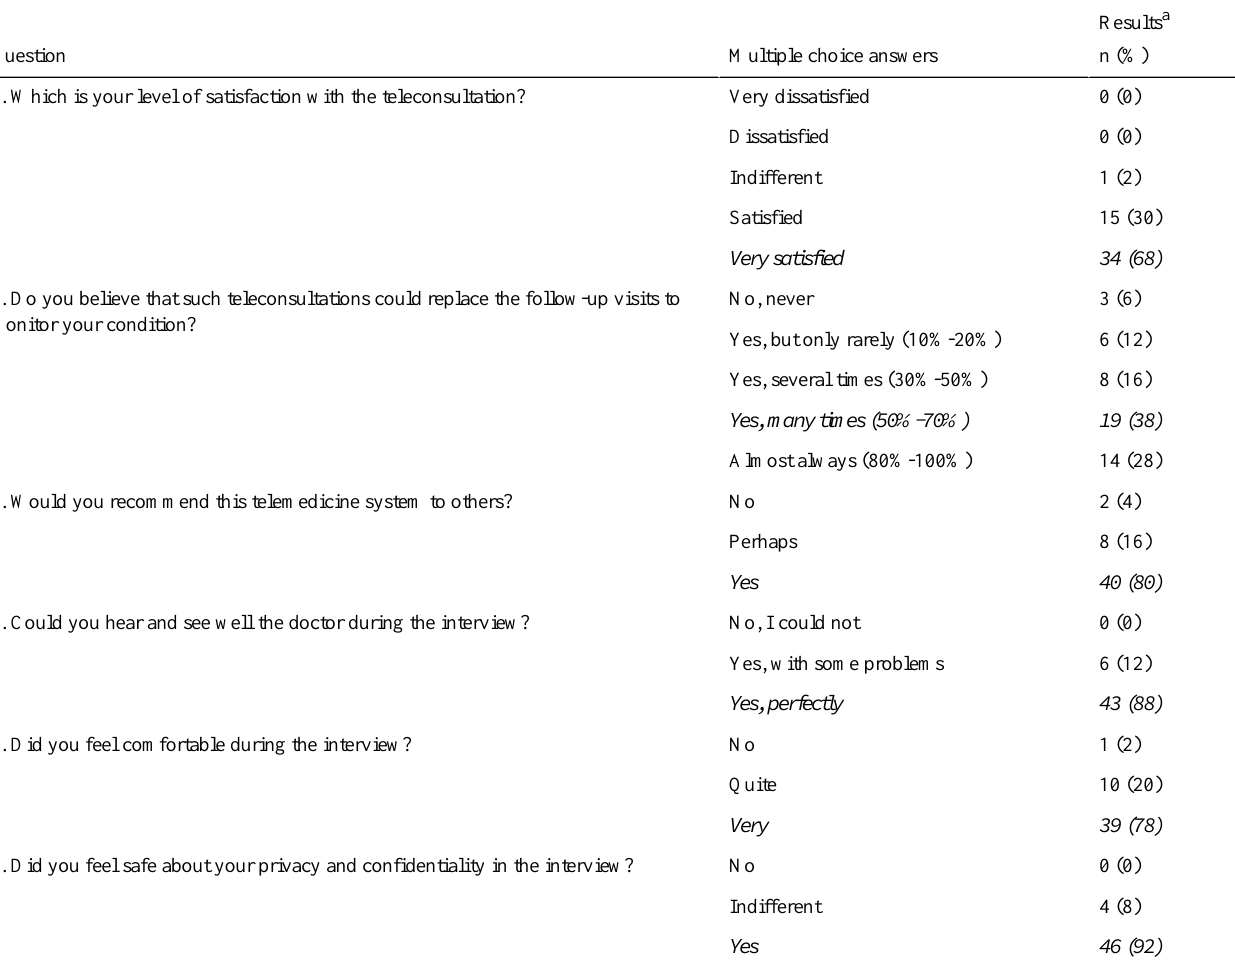
Table 2. Frequency distribution of the patients’answers to the opinion questionnaire about the teleconsultation (study 1; n=50).